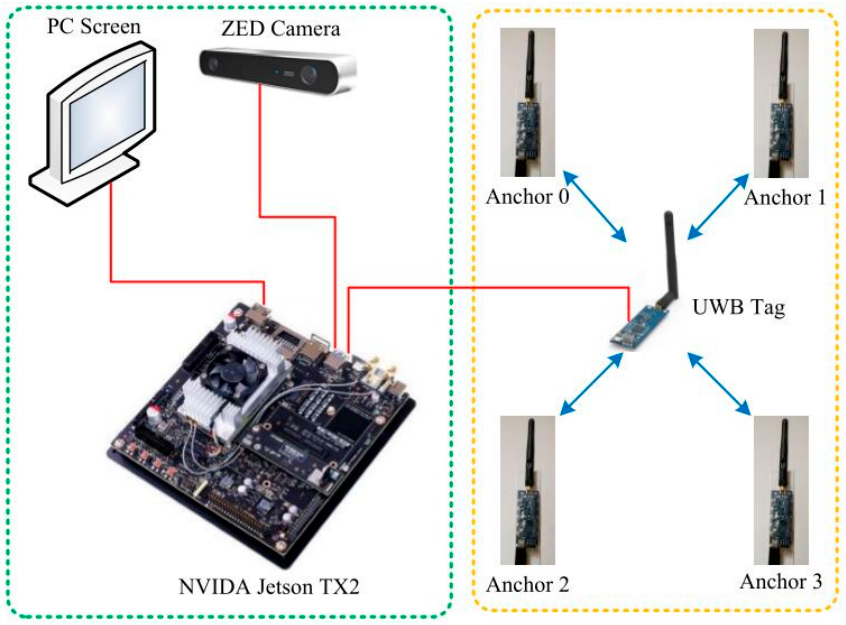
Figure 7. Hardware setup.